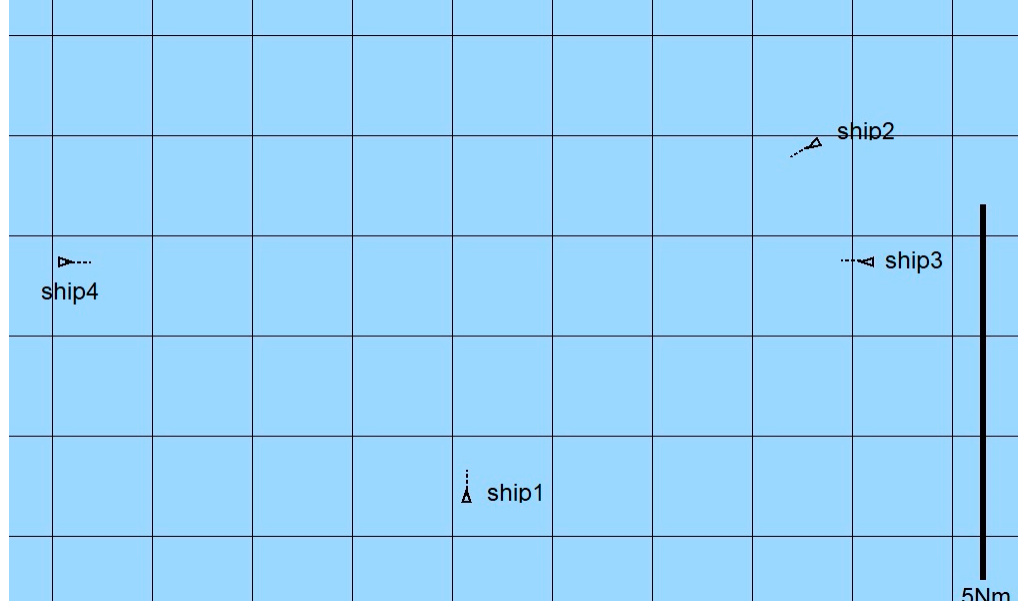
Figure 7. Physical model of the passenger ship Kołobrzeg used in the process of testing the AVAL technology.